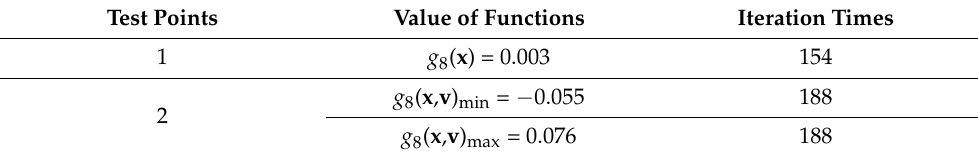
Table 5. The reliability analysis results of g 8